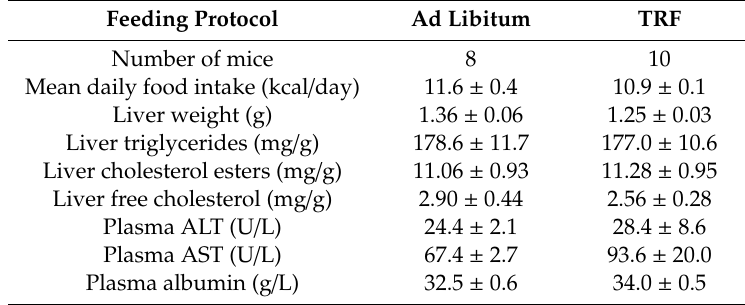
Table 1. Biochemical parameters of non-alcoholic fatty liver disease (NAFLD) in experimental mouse groups 1 .